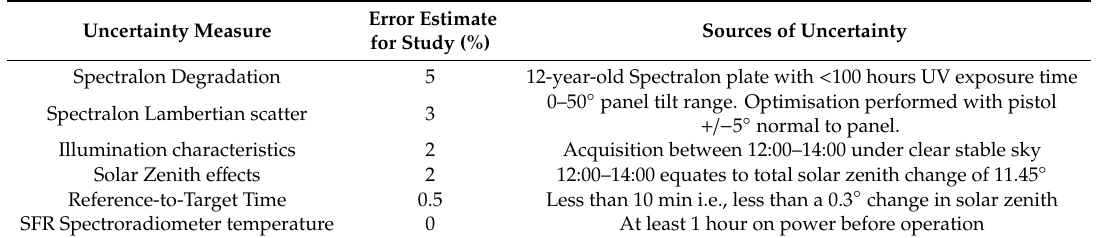
Table 4. Uncertainty measure attributes for the study design including study conditions that induce sources of